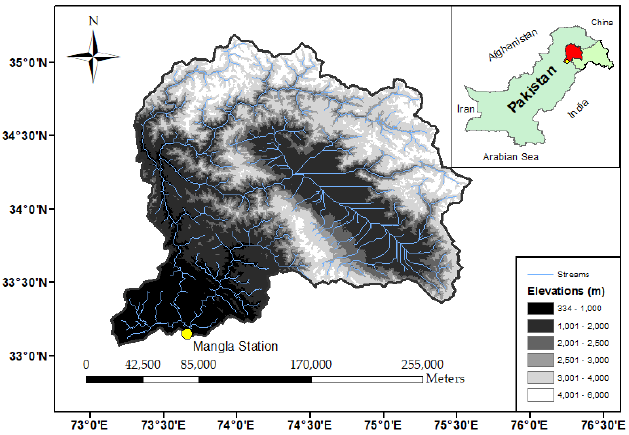
Fig. 5. The sub-surface unsaturated tank parameters and aquifer tank parameters are based on soil, surface and depth spread of computerized soil data of the World by FAO-UNESCO, which is also called digital soil map of the world (DSMW) [15,32-33]. The soil classification of the study area according to DSMW, is presented in Fig. 6 (A-B). The soil /geologic data and the land use data were up-scaled to 5×5 km 2 using the framework of IFAS Model.